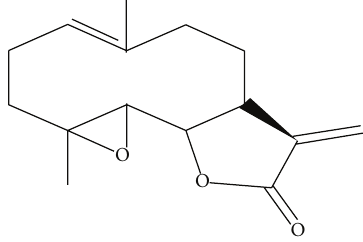
Figure 1: The chemical structure of